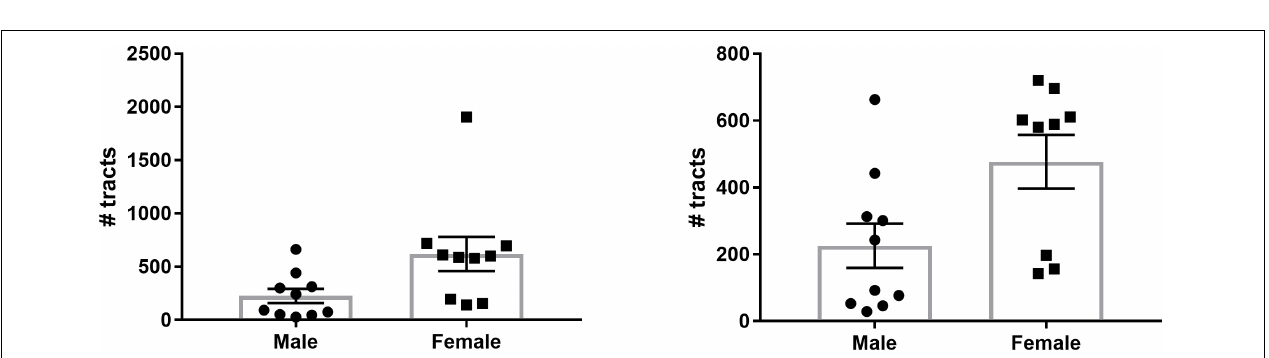
FIGURE 5 | Hemispheric asymmetry of LHb afferents/efferents. (Left) The majority (80%) of right-handed individuals had a greater number of streamlines in the left hemisphere. (Middle) Left-handed individuals did not demonstrate a consistent hemispheric asymmetry in streamline count. (Right) The log of the left:right streamline ratio for each individual is shown along with the group geometric mean. The geometric mean was significantly greater than 0 for right-handed individuals but not for left-handed subjects.